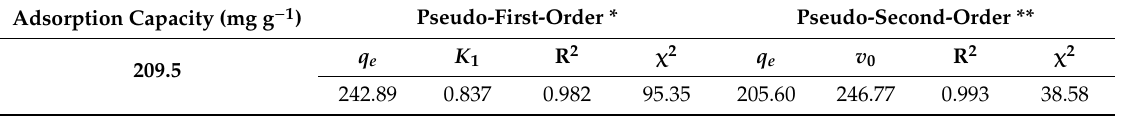
Table 1. Kinetic parameters of kinetic model for adsorption of methylene blue on